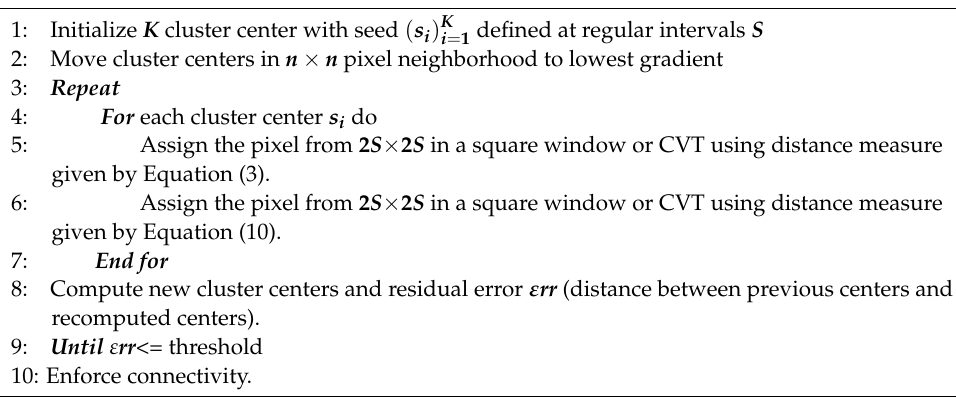
Algorithm 1. SLIC++